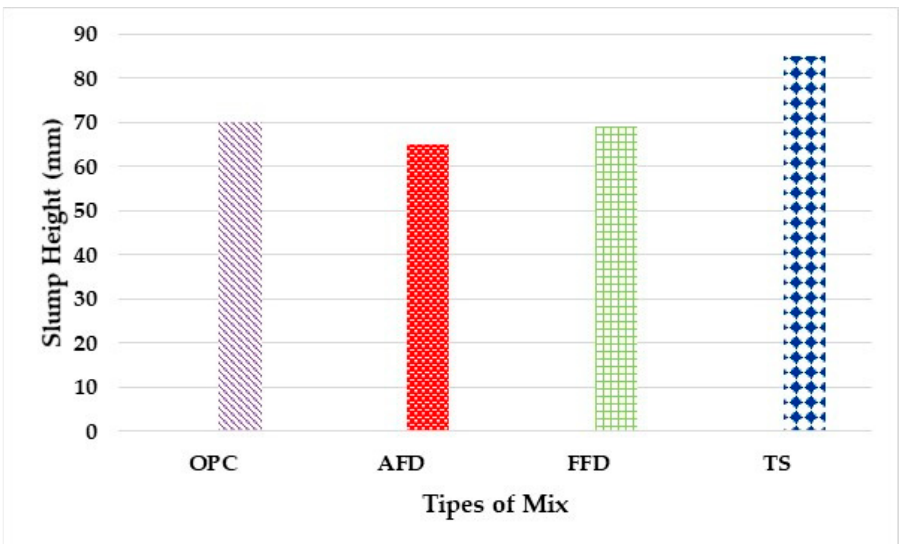
Figure 6. Workability of fresh concrete.